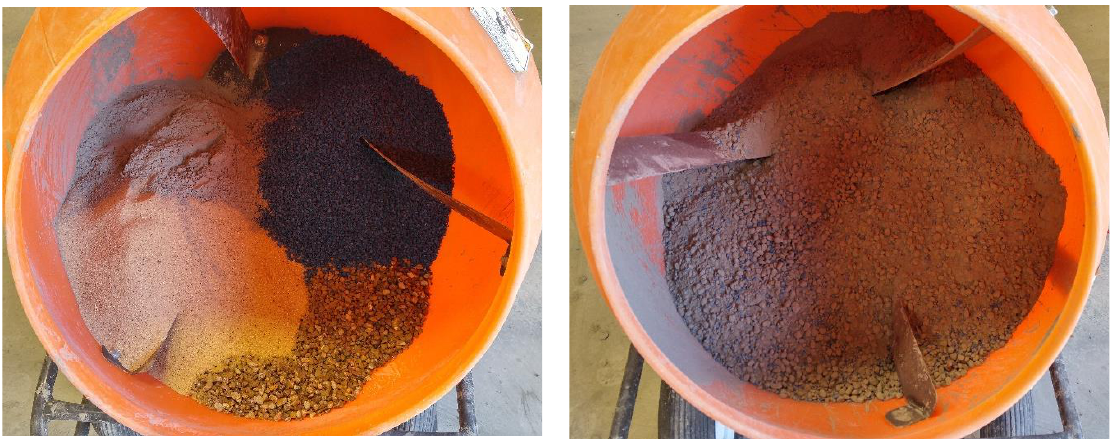
Figure 3. Dry mixing of concrete ingredients with crumb